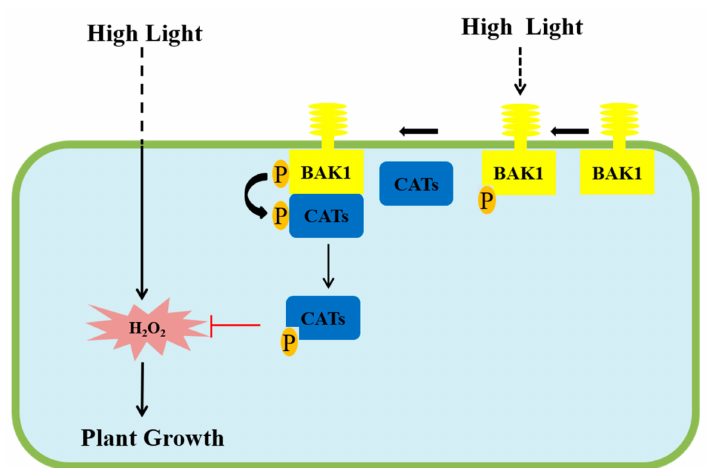
Figure 7. A proposed simplified model for the overexpression of BAK1 inhibiting high light-induced plant growth and development. High light can induce certain levels of H 2 O 2 accumulation which will eventually lead to the promotion of growth and development of Arabidopsis plants. In the transgenic Arabidopsis overexpressing BAK1 , high light can also induce the phosphorylation of the over-accumulated BAK1 kinase caused by the expression of the BAK1 gene, which in turn interacts with and phosphorylates catalases CAT1 / 2 / 3, resulting in the activation of CAT1 / 2 / 3. The activated catalase acts in scavenging H 2 O 2 , thereby leading to the arrest of high light-promoted growth and